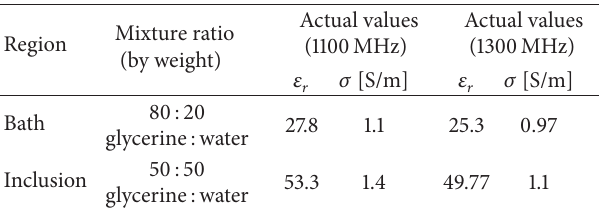
Table 1: Probe collected dielectric property values for the bath and inclusion region including their mixture composition (1100 and 1300